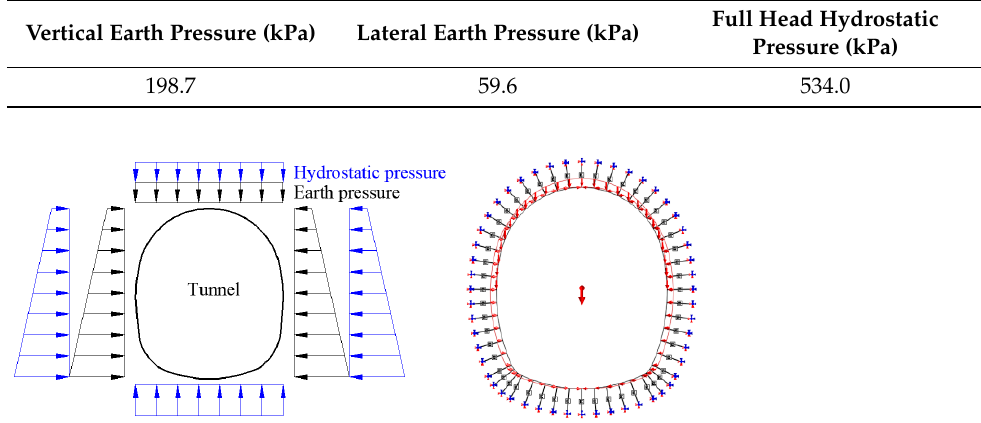
Table 8. The load calculation.